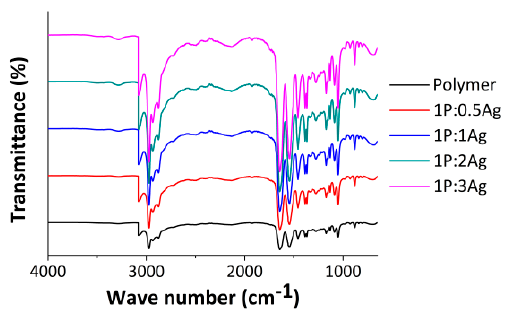
Figure 2. FT-IR spectra of the pure polymer A and the nanocomposites at different ratios P:Ag + at RT.